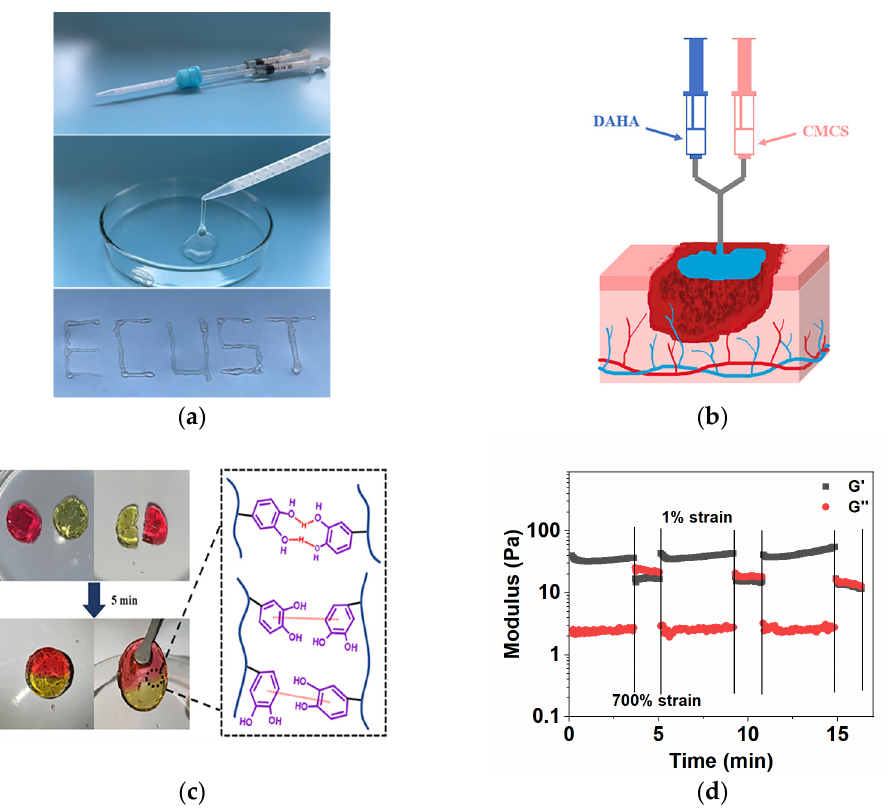
Figure 4. ( a ) Evaluation of injectability of the DACS with a double barrel spiral needle; ( b ) Schematic diagram of DACS hydrogel used for the wound; ( c ) Self-healing ability of DACS hydrogels and schematic diagram of the self-healing process; and ( d ) Rheological properties of DACS hydrogels under variable external strain (1–700%).